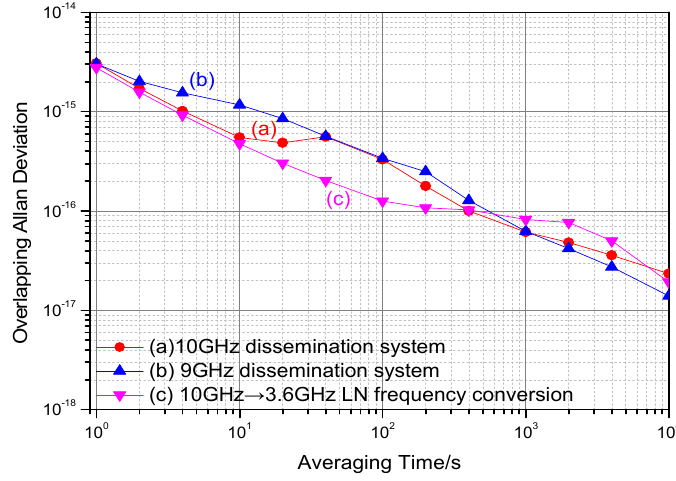
Figure 8. Stability of each segment.